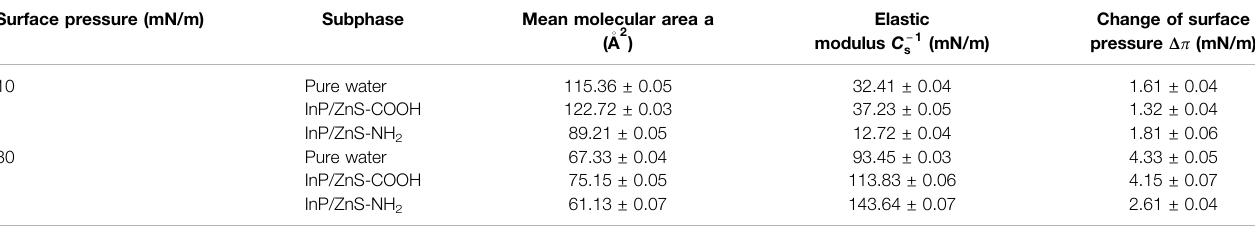
TABLE 1 | Relevant characteristic parameters of the DPPC/DPPG mixed monolayer spread on the surface of different subphases. Surface pressure